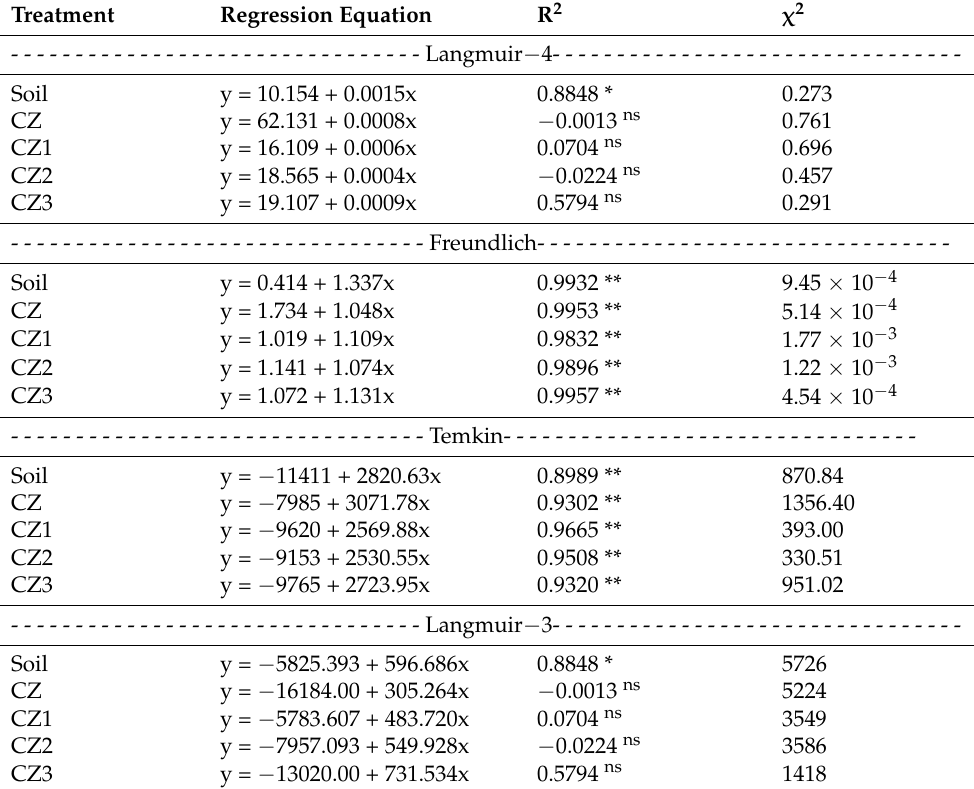
Table 13. Fitting Langmuir type 4, Freundlich, and Temkin isotherms to the nitrogen adsorption data based on simple regression and Chi-square analyses